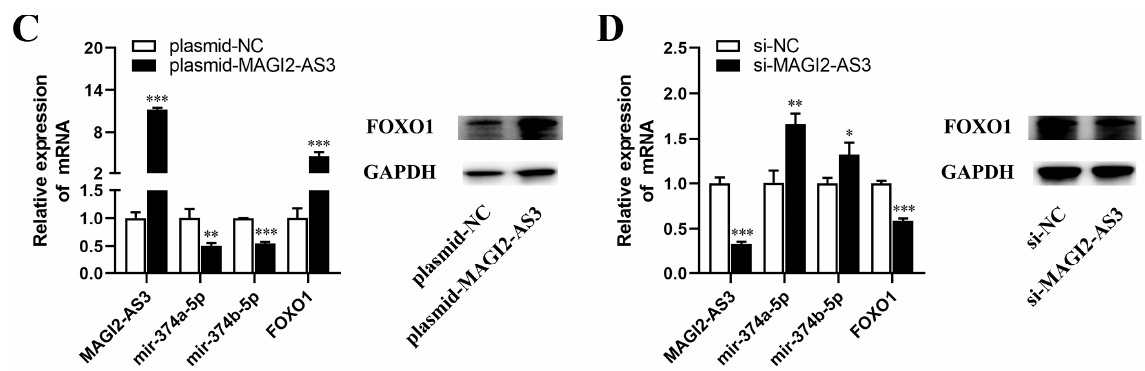
Figure 7. ( A ) Sequences of MAGI2-AS3/miR-374a/b-5p binding site predicted by StarBase 2.0. MiR- 374a/b-5p mimics only reduced MAGI2-AS3-wt luciferase activity. ( B ) Sequences of miR-374a/b-5p /FOXO1 binding site predicted by StarBase 2.0. MiR-374a-5p/miR-374b-5p mimics only reduced FOXO1-wt luciferase activity. ( C ) QRT-PCR shows that MAGI2-AS3 and FOXO1 expression were increased and miR-374a/b-5p was decreased, and western blot results showed that FOXO1 protein level was increased due to overexpression of MAGI2-AS3. ( D ) QRT-PCR results showed that mRNA levels of MAGI2-AS3 and FOXO1 expression were decreased and miR-374a/b-5p was increased, and western blot results showed that the FOXO1 protein level was decreased due to the inhibition of MAGI2-AS3. * p < 0.05, ** p < 0.01, *** p < 0.001. MAGI2-AS3, MAGI2 antisense RNA 3. WT, wild type. Mut, mutant.